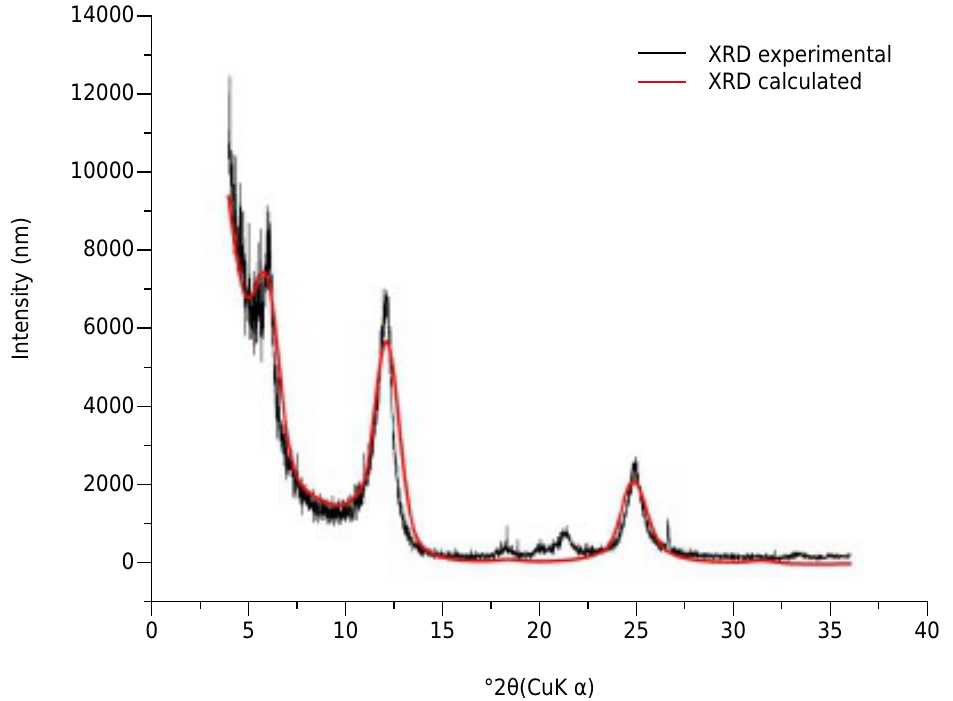
Figure 2. Comparative between experimental diffractogram (obtained by X-ray diffraction) and calculated diffractogram (obtained through NEWMOD ® ) referred to the Profile 1, B horizon, total clay fraction of Latossolo Bruno from Vacaria, RS